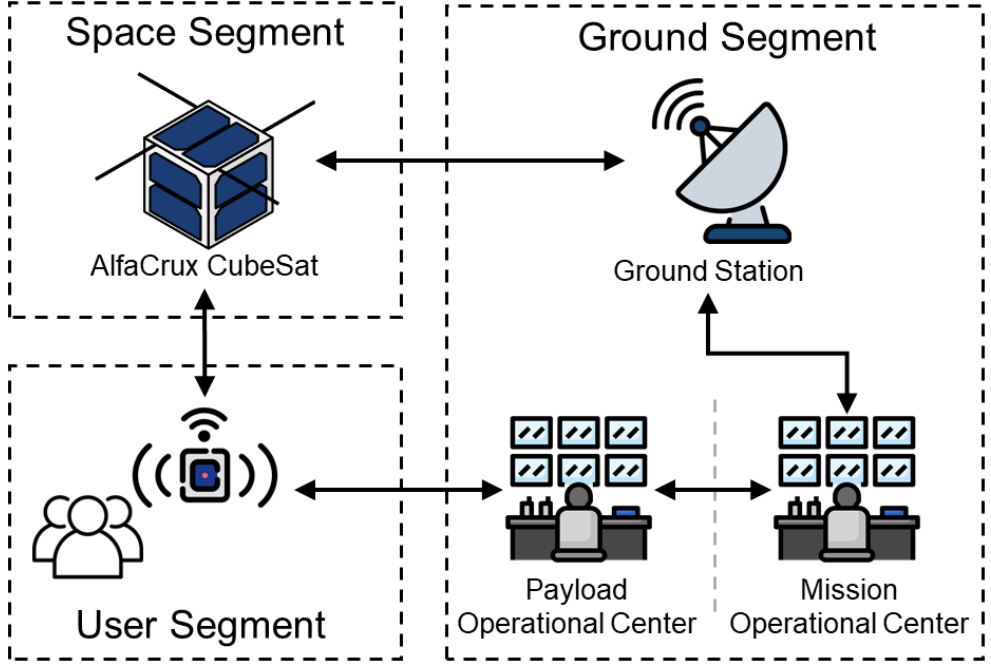
Figure 2. AlfaCrux operational